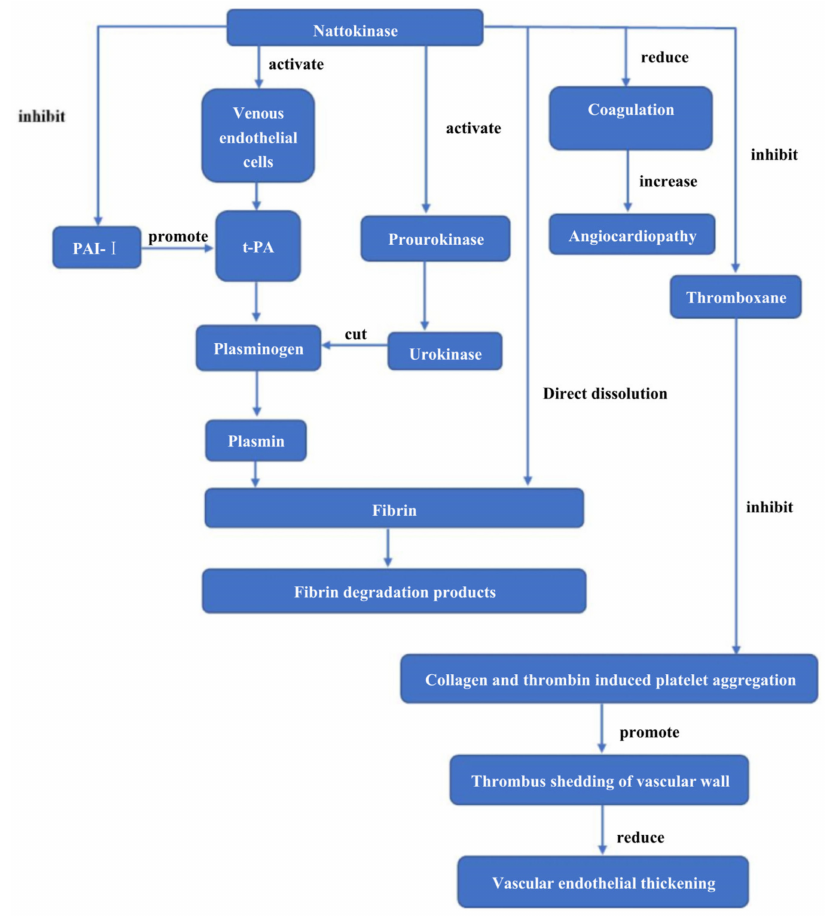
Figure 3. Thrombolytic mechanism of